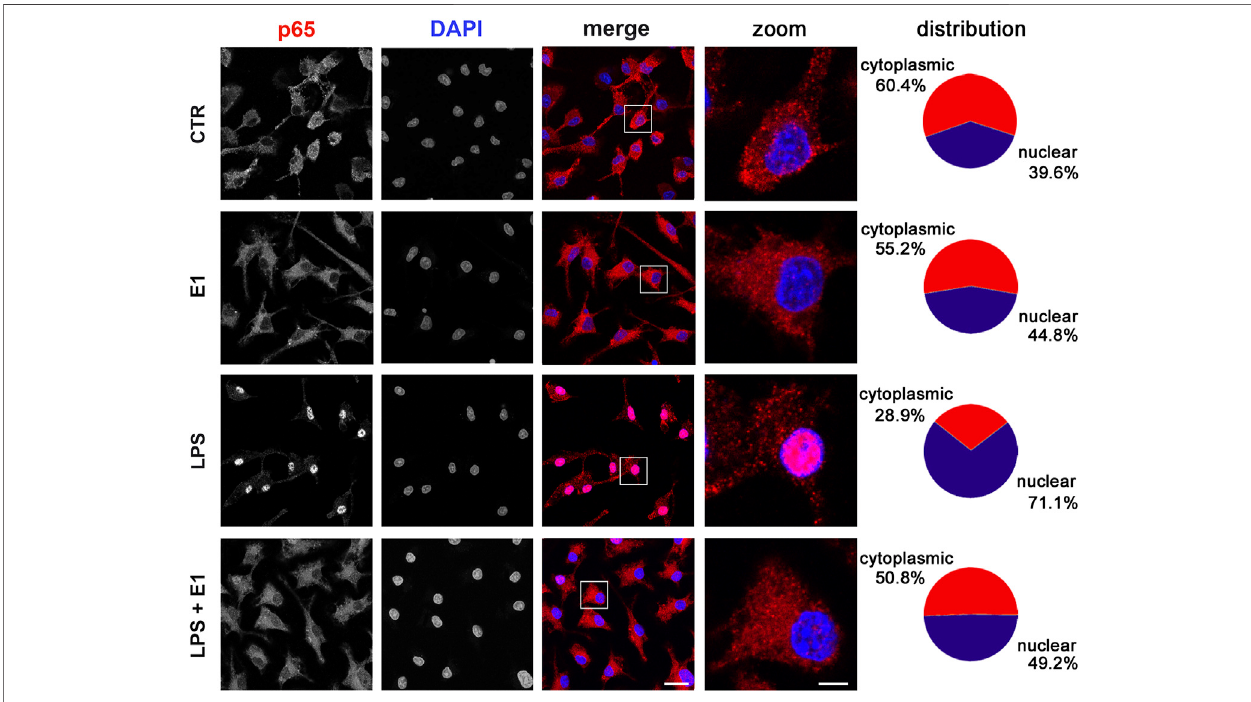
FIGURE 5 | Effect of Spirulina extract on NF- κ B activation in unstimulated and LPS-stimulated microglia. Cells were cultured for 24 h in 10% serum-containing medium, which was replaced with serum-free medium before pre-treatment with 100 μ g/ml E1 followed by stimulation with 100 ng/ml LPS. Cells were then processed forNF- κ Bp65immunostaining(red)and nucleiwerecounterstainedwithDAPI(blue).Experimentswereperformed3timesandrepresentativeconfocalimagesshowing subcellular localization of p65 are shown. Scale bars in merged and zoomed images, 10 and 2 μ m, respectively. The fl uorescence intensity of cytoplasmic and nuclear p65 subunit was calculated using ImageJ software and results are presented as percentage of nuclear and cytoplasmic NF- κ B p65 distribution in the fi fth column. Data are mean from three independent experiments.